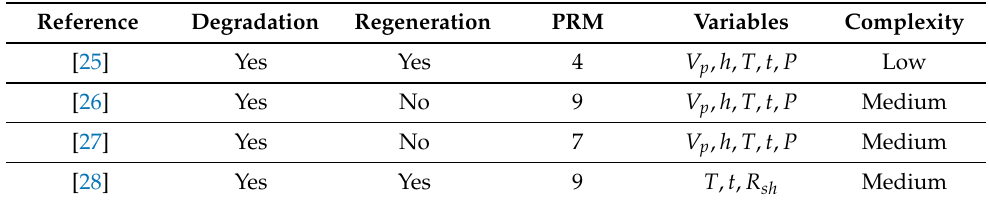
Table 2. Potential induced degradation (PID) models with electrical-related input for PVMs. PRM: the number of parameters to